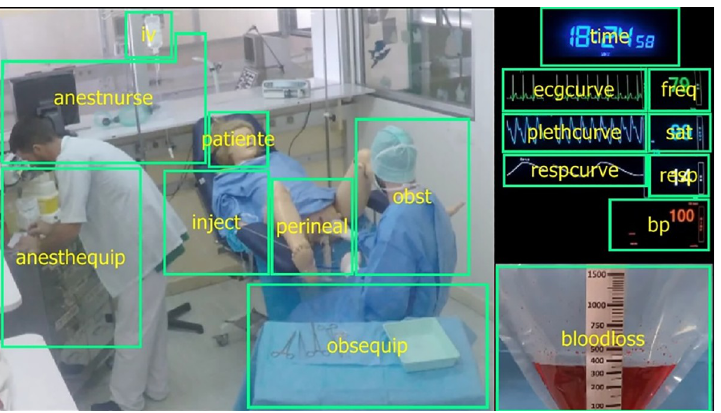
Fig 2. Screenshot presenting the video clip and the repartition of the region of interest. The two actors managed a simulated patient: the nurse on the left, the obstetrician on the right and the high-fidelity manikin in the center. Time, monitoring and quantification of bleeding were inserted on the right of the screen to improve the readability of the information and to better discriminate eye movements. The 17 yellow boxes correspond to the previously defined ROI. “iv” : corresponds to vascular filling fluids, “anestnurse” : nurse anesthesiologist, “anesthequip” : equipment of the anesthetist, “patient” : Noelle 1 face, “inject” : injection site in the perfusion, “perineal” : perineal area, “obst” : obstetrician, “obsequip” : obstetrical material, “time” : hour of the action. “Ecgcurve” : heart rate curve, “freq” : heart rate, “plethcurve” : plethysmography curve, “sat” : oxygen saturation of the blood, “respcurve” : respiratory rate curve, “resp” : respiratory rate, bBp” : blood pressure, “bloodloss” : blood collection bag.